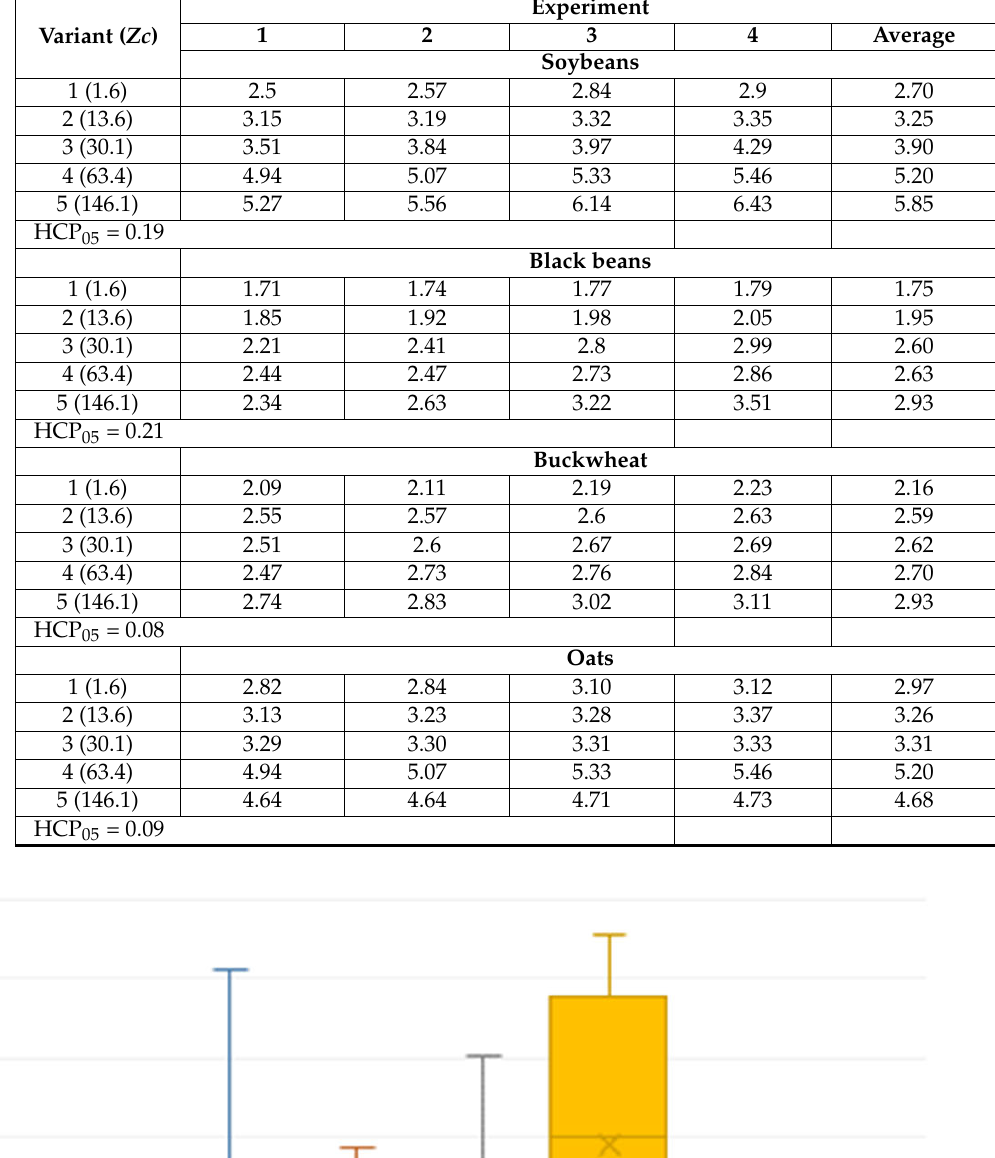
Table 4. Lead content in the phytomass of test crops, mg/kg.